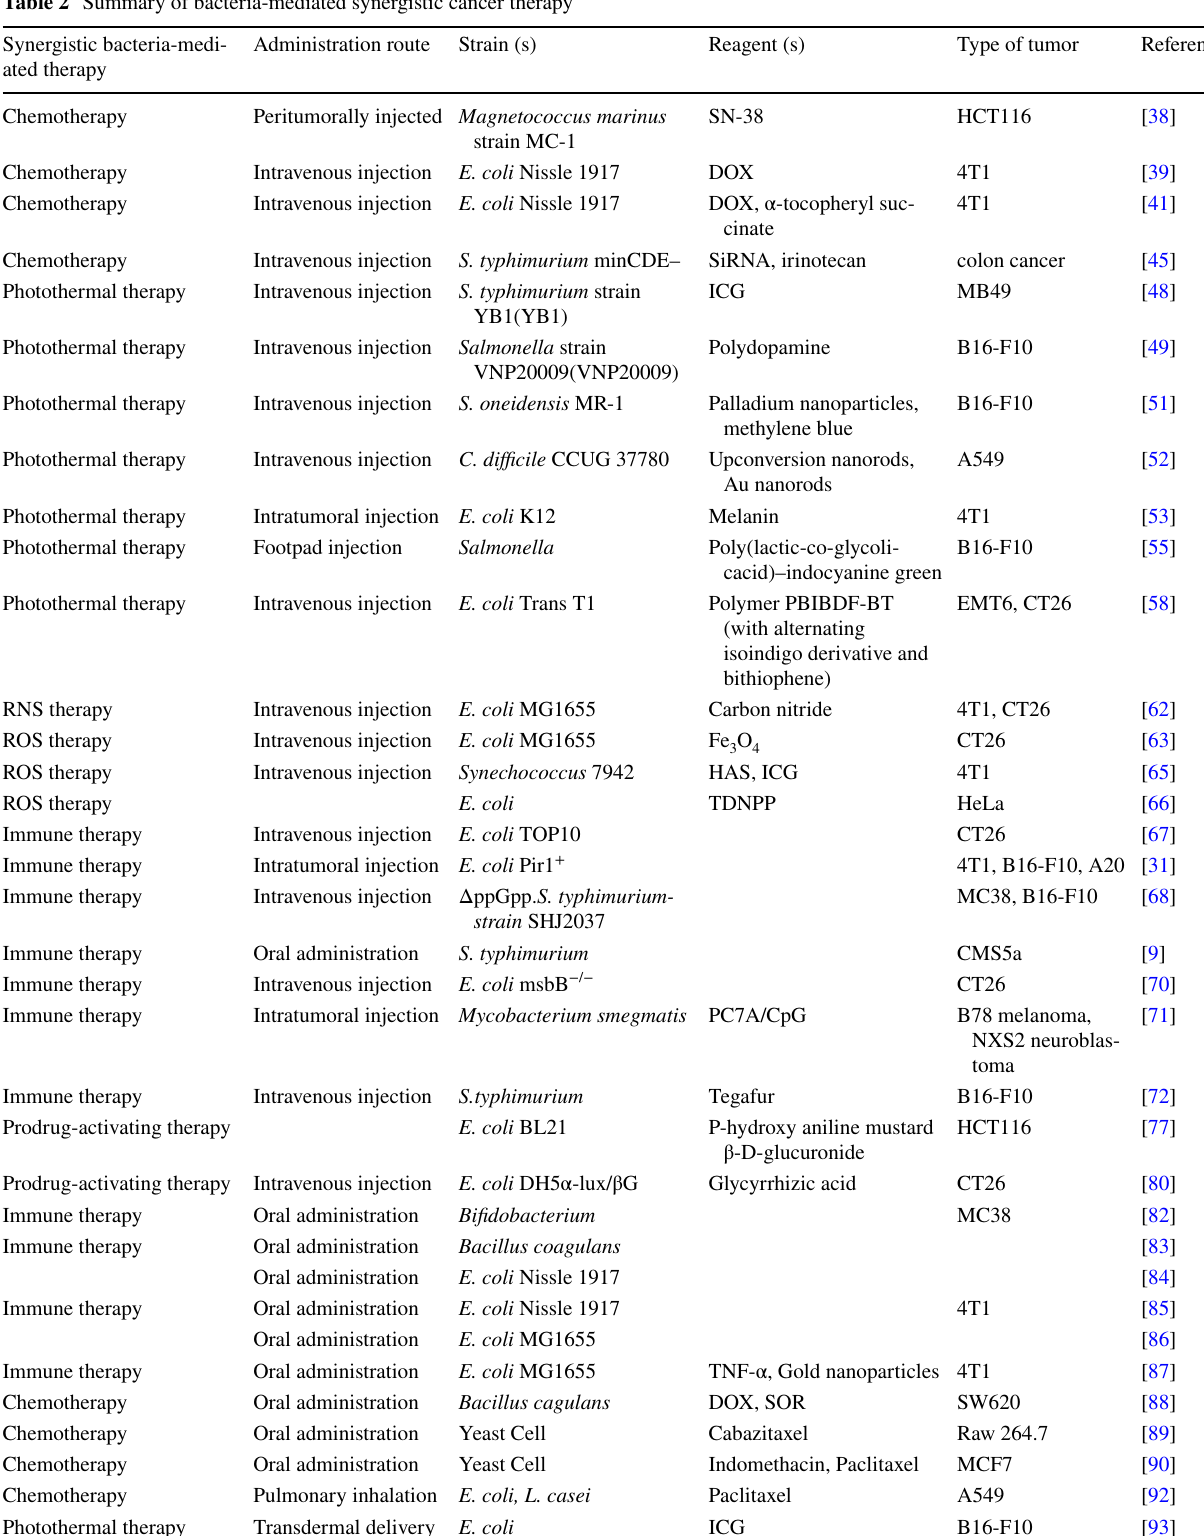
Table 2 Summary of bacteria-mediated synergistic cancer therapy Synergistic bacteria-medi- ated